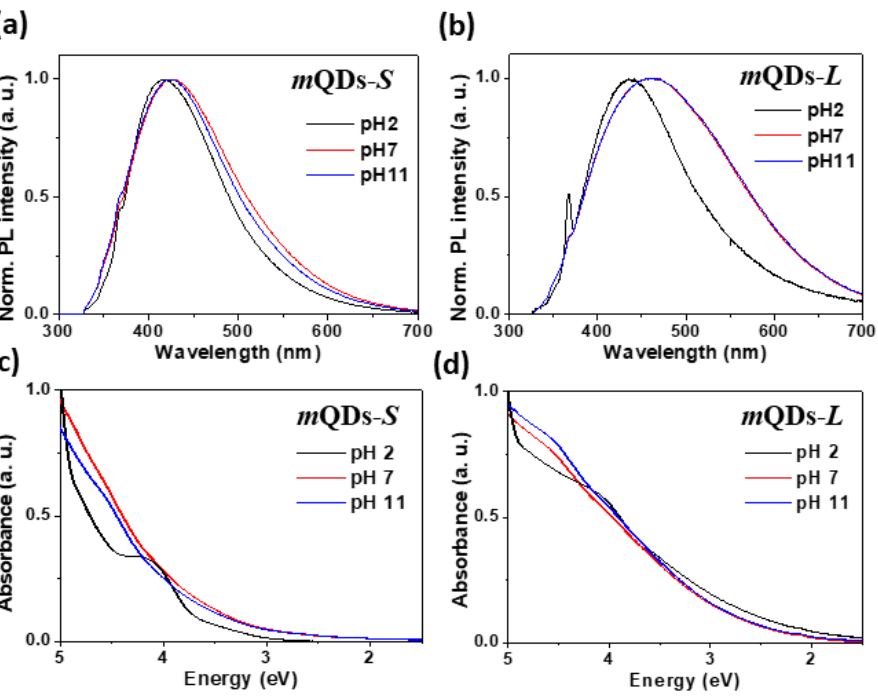
Figure 2. Photoluminescence (PL) spectra and UV-vis absorbance. ( a , b ). PL spectra of MoSe 2 - m QD- S ( a ) and MoSe 2 - m QD- L ( b ) measured with an excitation wavelength of 325 nm. ( c , d ). UV absorbance of MoSe 2 - m QD- S (left) and MoSe 2 - m QD- L (right).